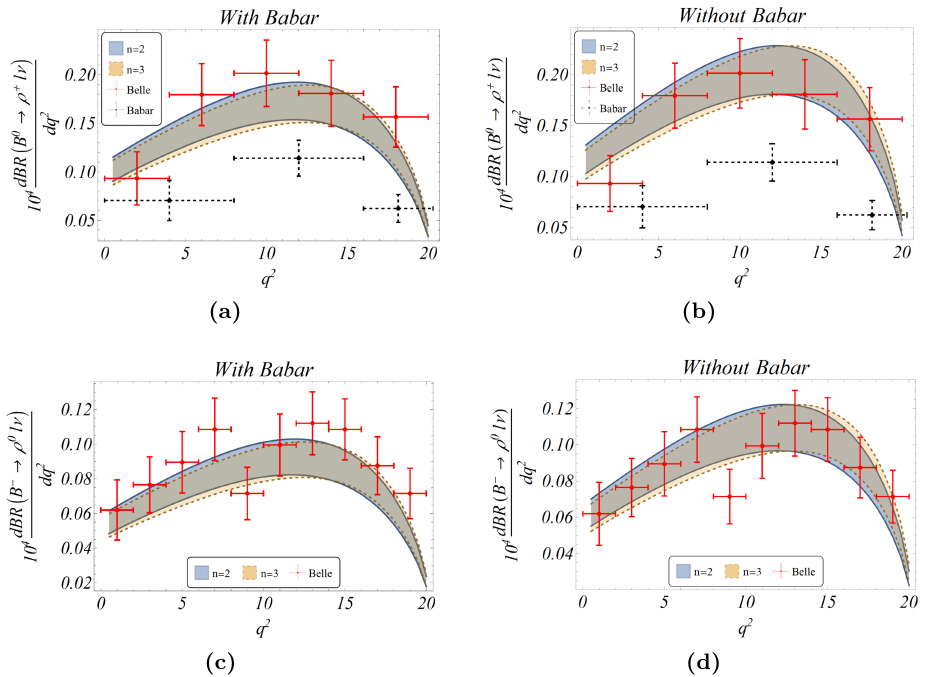
for neutral and charged B to ρ semileptonic decays Figure 3. Plots showing the variation of d B dq 2 corresponding to the fit results where the dataset includes ((a) and (b)) or does not include ((c) and (d)) the three Babar datapoints. It can clearly be seen that the inclusion of the Babar data results in the fit not being able to incorporate most of the data from Belle, whereas excluding them immediately results in a much more acceptable scenario. We have used V = (3 . 91 ± 0 . 13) × 10 − 3 ub which is an update on the result reported by [3] after the inclusion of the LCSR data on B → π form factors from